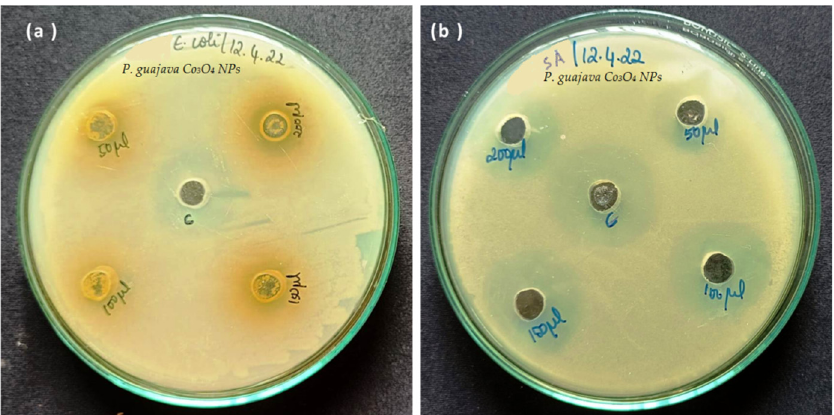
Figure 9. Anti-bacterial activity of green synthesized Psidium guajava Co 3 O 4 NPs against ( a ) gram- negative bacteria ( E. coli ) ( b ) gram-positive ( S. aureus ). Table 2. Zone of inhibition of green synthesized Psidium guajava Co 3 O 4 NPs against gram +ve ( Staph- ylococcus aureus ) and gram − ve ( Escherichia coli ) bacteria. Results are represented as mean ± SD, trip- licate measures.